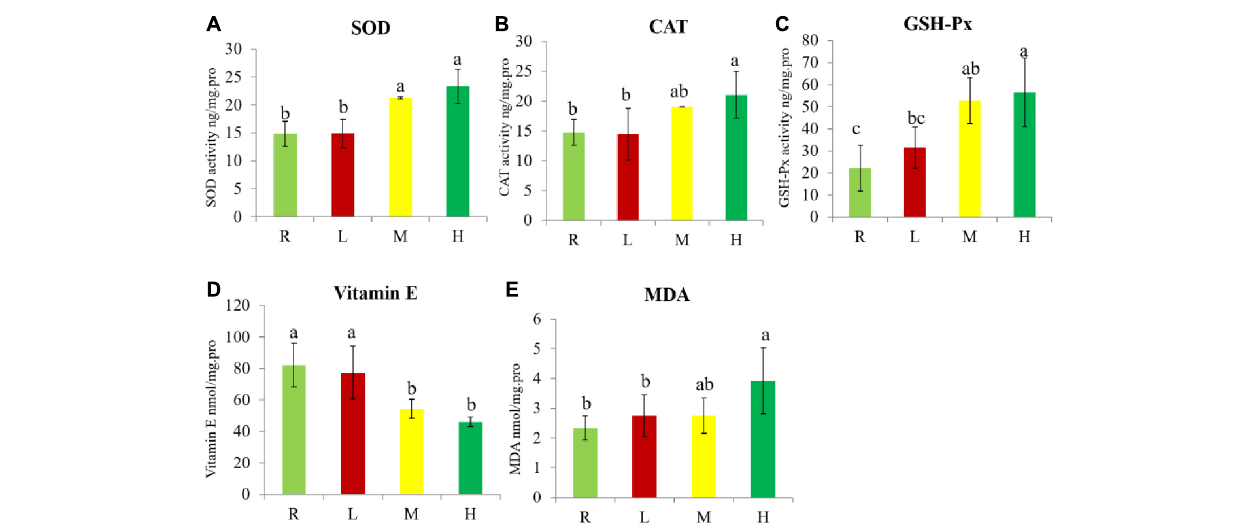
FIGURE 2 | Antioxidant enzyme, Vitamin E, and MDA concentration in spleen of hybrid grouper. (A) Superoxide dismutase (SOD); (B) catalase (CAT); (C) glutathione peroxidase (GSH-Px); (D) vitamin E concentration; (E) malondialdehyde (MDA). Diverse little letters above histogram bars indicate significant differences ( P < 0.05) in different dosage groups in Duncan’s multiple range tests, n = 3.